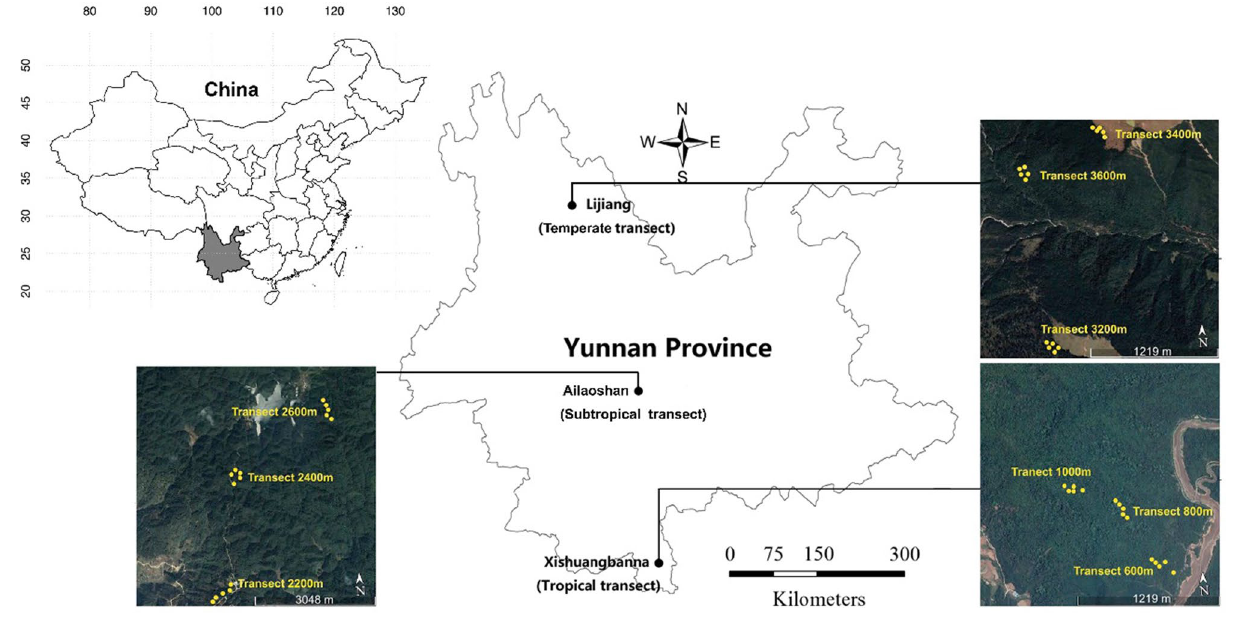
Figure 3. Geographical location of the three sampling sites, nine sampling transects and 45 sampling plots in the east Himalayan Mountains, Yunnan province, Southwest China, the basic map is generated in R 3.4.5, and ‘.shp’ file is from the open resources of National Catalogue of Service For Geographic Information (https :// www.webma p.cn/main.do?metho d=index ) under the regulations of Surveying and Mapping Law of the People’s Republic of China (2017), and the sampling topographic map is generated with Google earth (Google Earth Pro 7.3.3.7786 (64-bit)) with the permission of GOOGLE TERMS OF SERVICE (https ://polic ies.googl e.com/terms